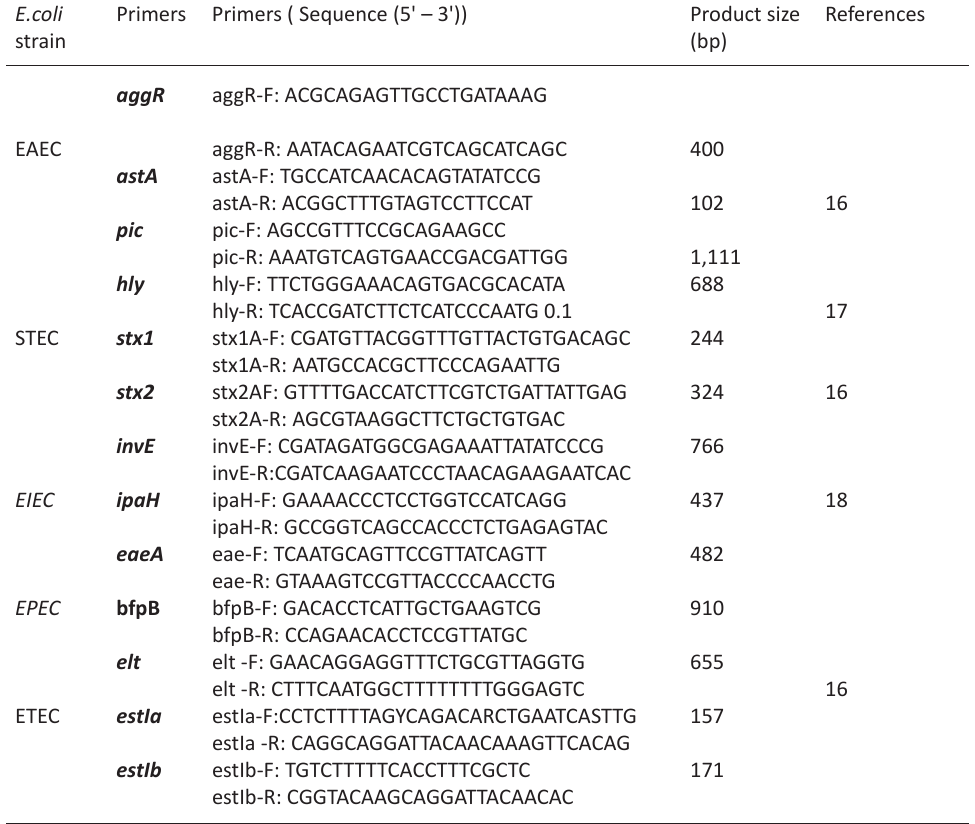
Table 1. Primers used for multiplex PCR reaction